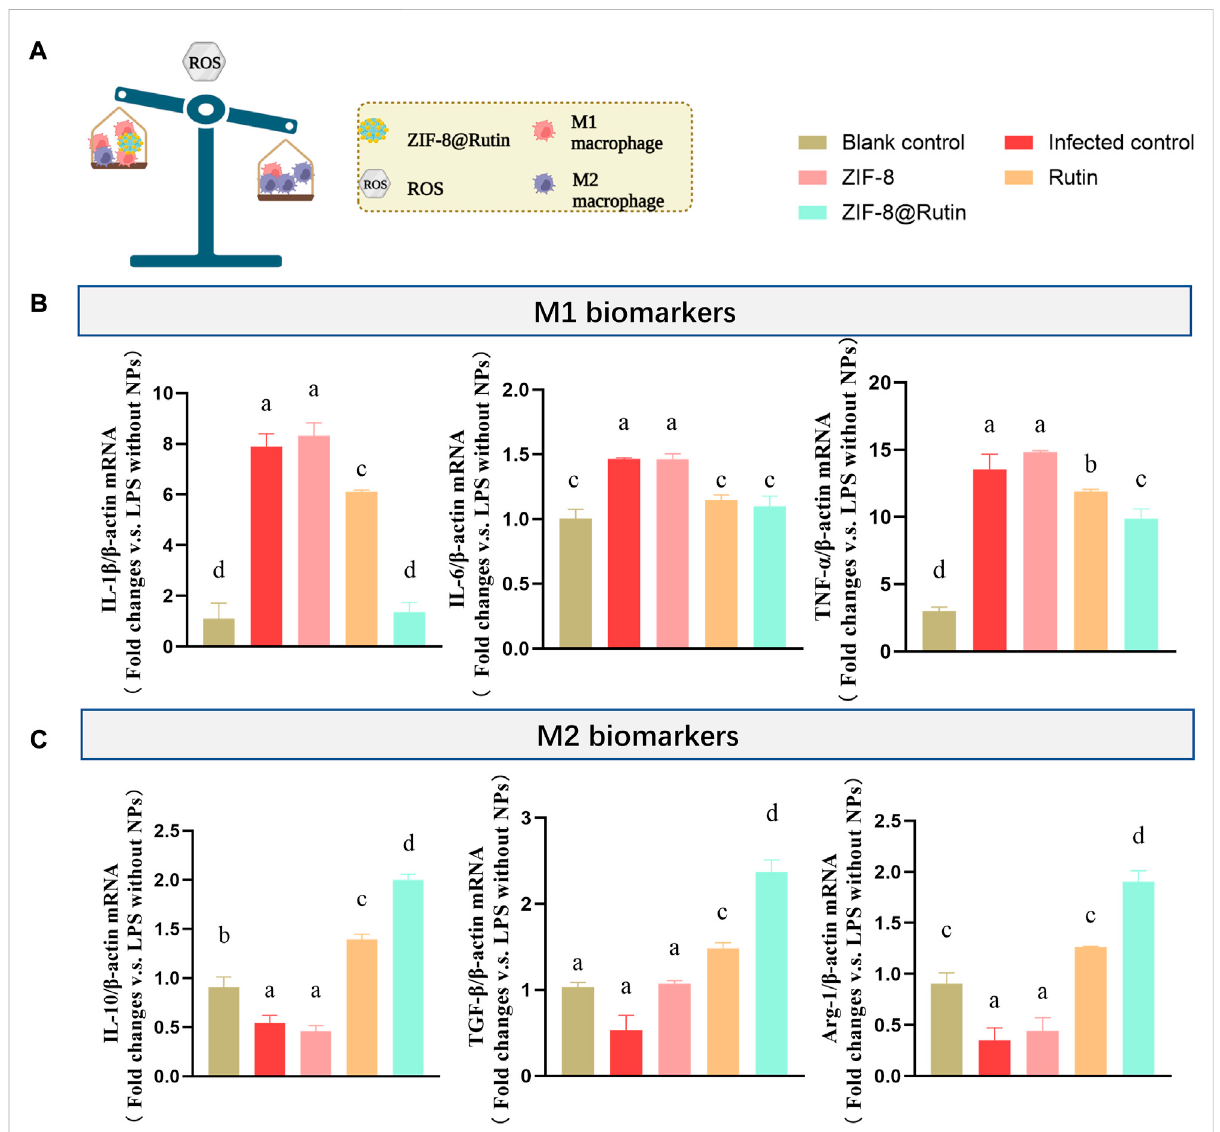
Schematicrepresentationoftheeffectofnanocompositesoninducedmacrophagepolarization. (A) Schematicrepresentationofin fl ammation regulation by ZIF-8@Rutin NPs. (B) mRNA expression of pro-in fl ammatory cytokines (IL-1 β , IL-6 and TNF- α ) and (C) mRNA expression of anti- in fl ammatory cytokines (IL-10, TGF- β and Arg-1) after 3 h treatment with LPS (1 μ g ml − 1 ) and 24 h co-culture with ZIF-8 (30 μ g ml − 1 ), Rutin (40 μ g ml − 1 ), ZIF-8@Rutin (40 μ g ml − 1 ), respectively. (Values for blank group calibrated to 1. n = 3; mean ± sd; In each graph, the values of different letters differ signi fi cantly from each